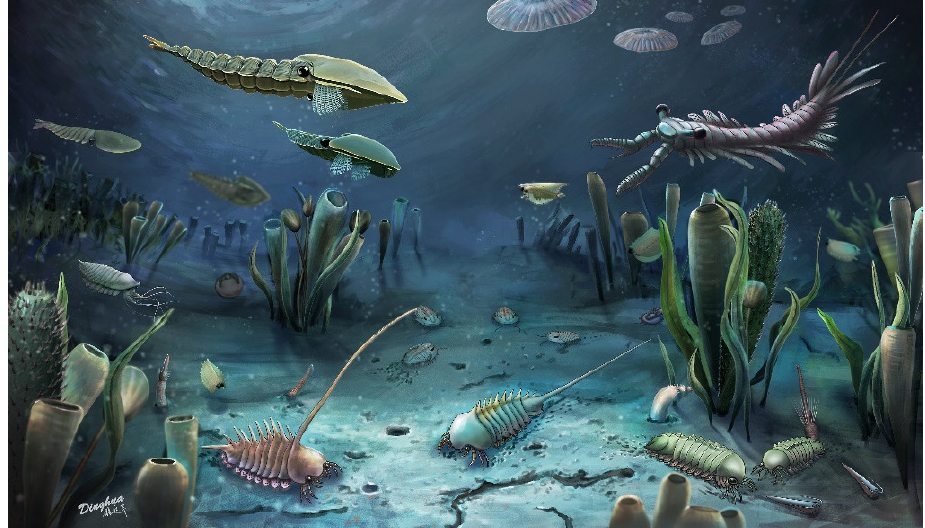
Figure 6. Reconstruction of the latest discovered Middle Cambrian Lagerstätte Lingyi Biota in Shandong (credit to Fangcheng Zhao).